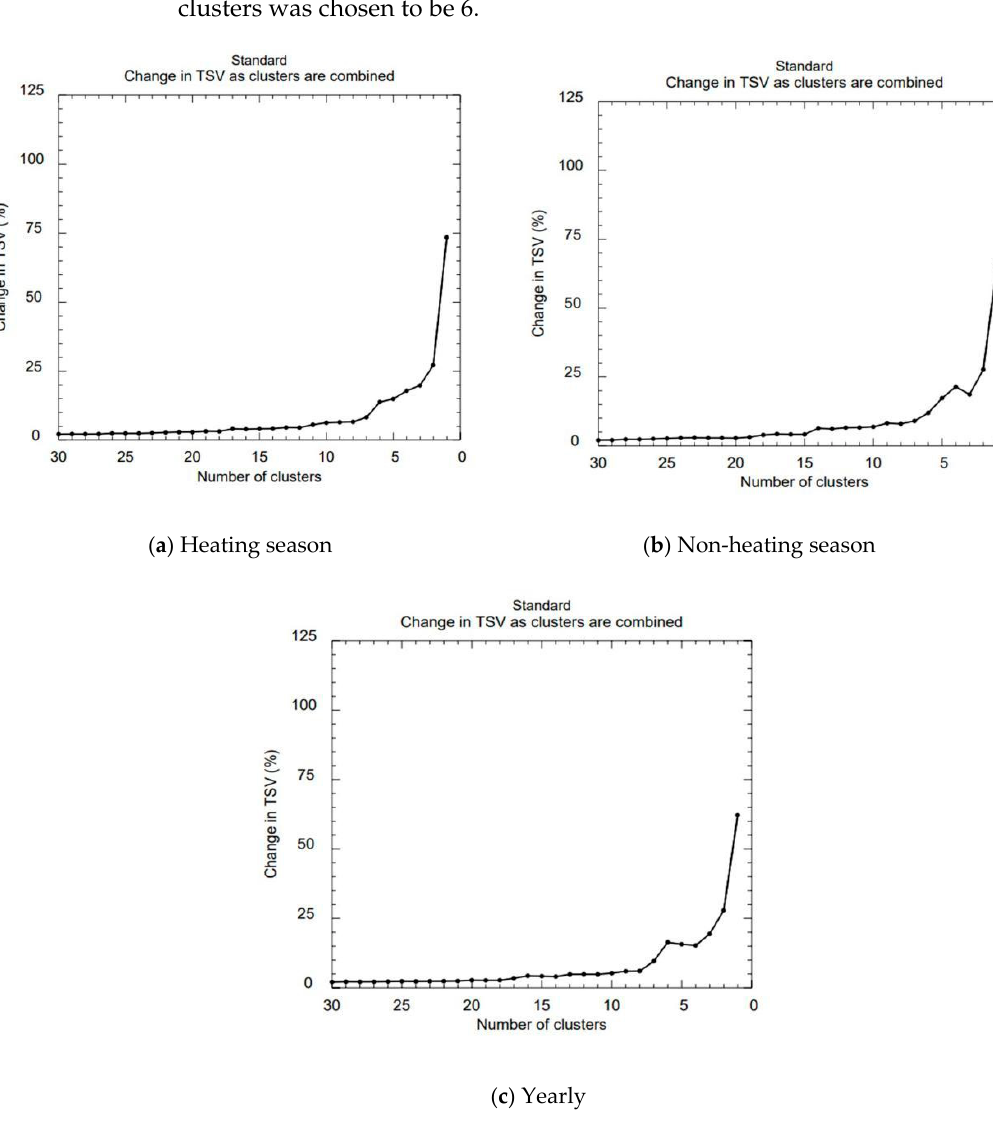
Figure 6. Changes in TSV (total spatial variance) as clusters are combined.